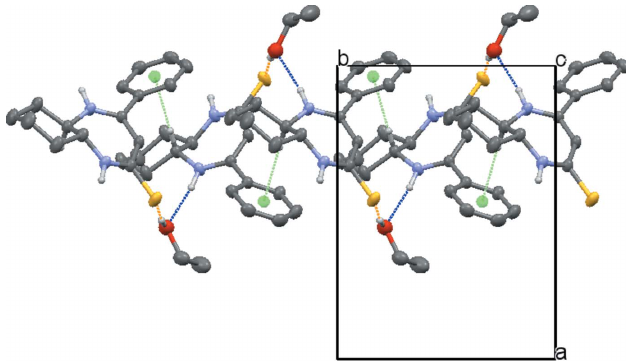
Figure 2 Portion of one chain viewed along the c -axis direction. N—H (cid:2)(cid:2)(cid:2) O and O—H (cid:2)(cid:2)(cid:2) S hydrogen bonds and the C—H (cid:2)(cid:2)(cid:2) (cid:2) (ring) interactions are shown, respectively, by blue, orange and green dashed lines.